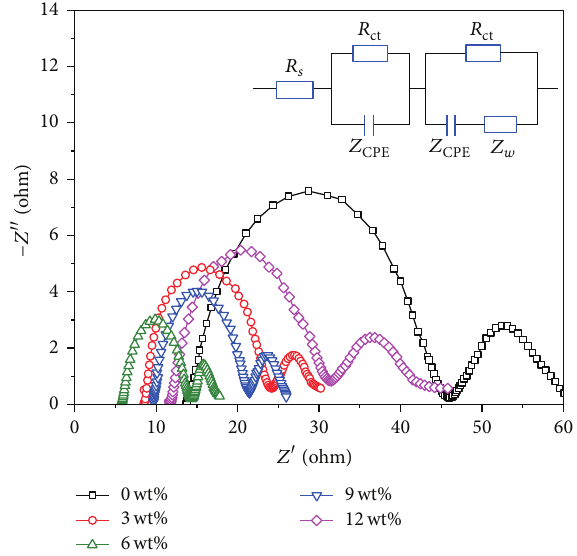
Figure 4: Nyquist diagram of thin-layer cells with various contents of VMT and the inset shows the equivalent circuit.